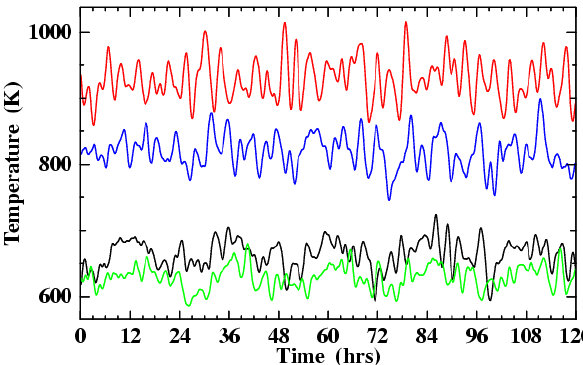
Fig. 4. Temperature variations at a constant-pressure surface ( ∼ 302–312km) at 76 ◦ N latitude and 17 ◦ E longitude during (a) 1– 5 March (black line), (b) 1–5 June (red line), (c) 1–5 September (blue line), and (d) 1–5 December (green line). The calculated val- ues are plotted every 10min. The values on the abscissa axis indi- cate hours from 00:00UT on the 1st day of each month. GCM simulations (not shown here). The localised structures seen in Figs. 1 and 3 seem to extend in about 20 ◦ latitude and 30 ◦ –60 ◦ longitude